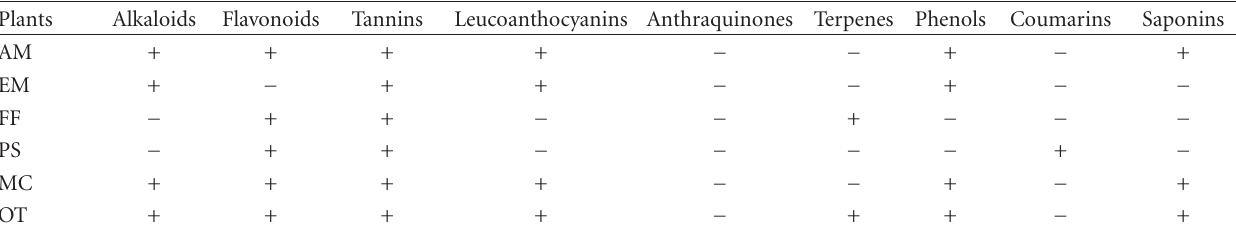
Table 4: Phytochemicals components of AM, EM, FF, OT and PS leaves and MC fruits.